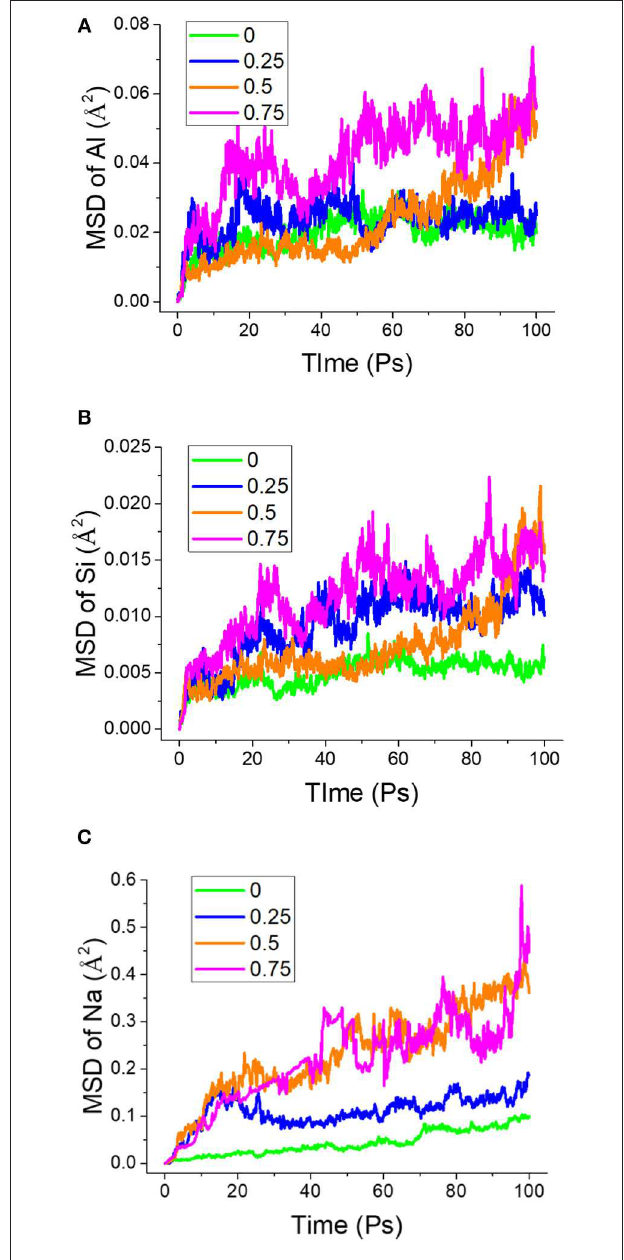
FIGURE 7 | Mean square displacement of (A) Al, (B) Si, and (C) Na under the influence of leaching.